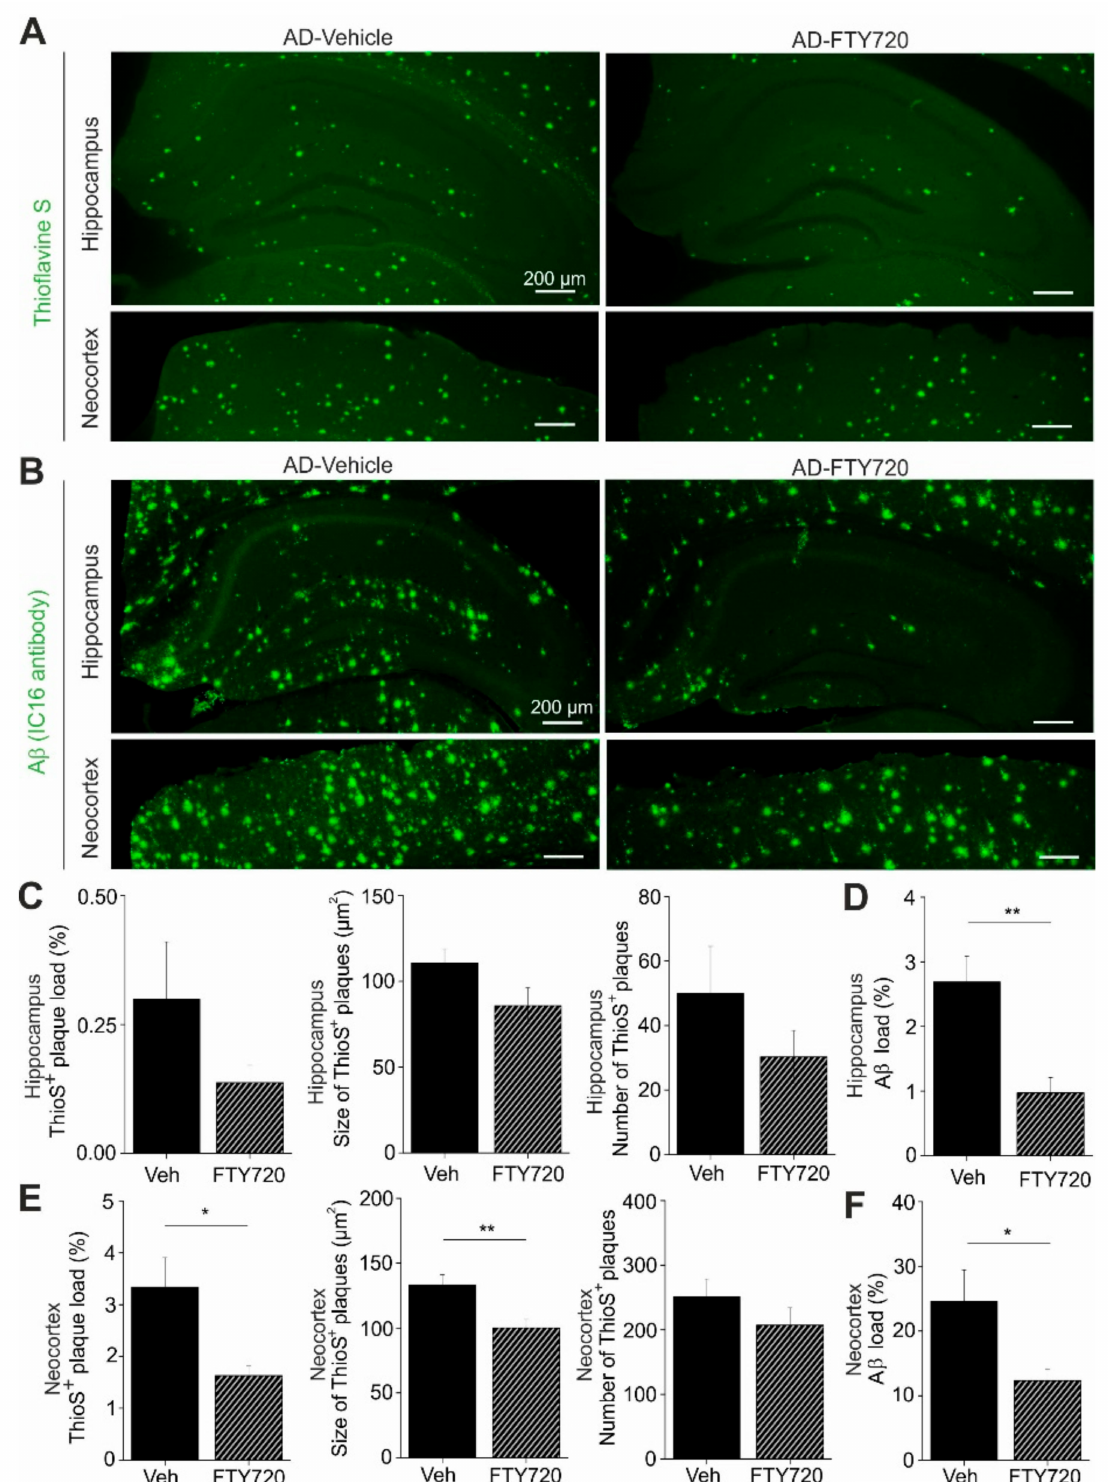
Figure 6. A β plaques and other A β deposits are reduced in fingolimod (FTY720) treated APP / PS1 mice. Five- to six-month-old male APP / PS1 mice were treated with i.p. injections of fingolimod for one to two months and analyzed for A β depositions at six to seven months of age. ( A ) A β plaques in the hippocampus (upper panels) or in the neocortex (lower panels) were stained with green